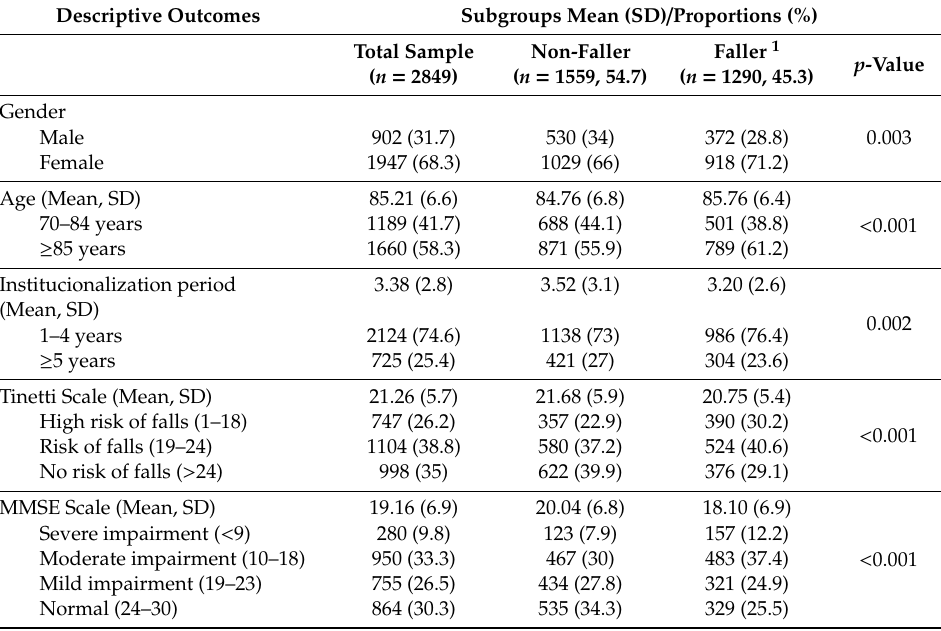
Table 1. Descriptive characteristics of the